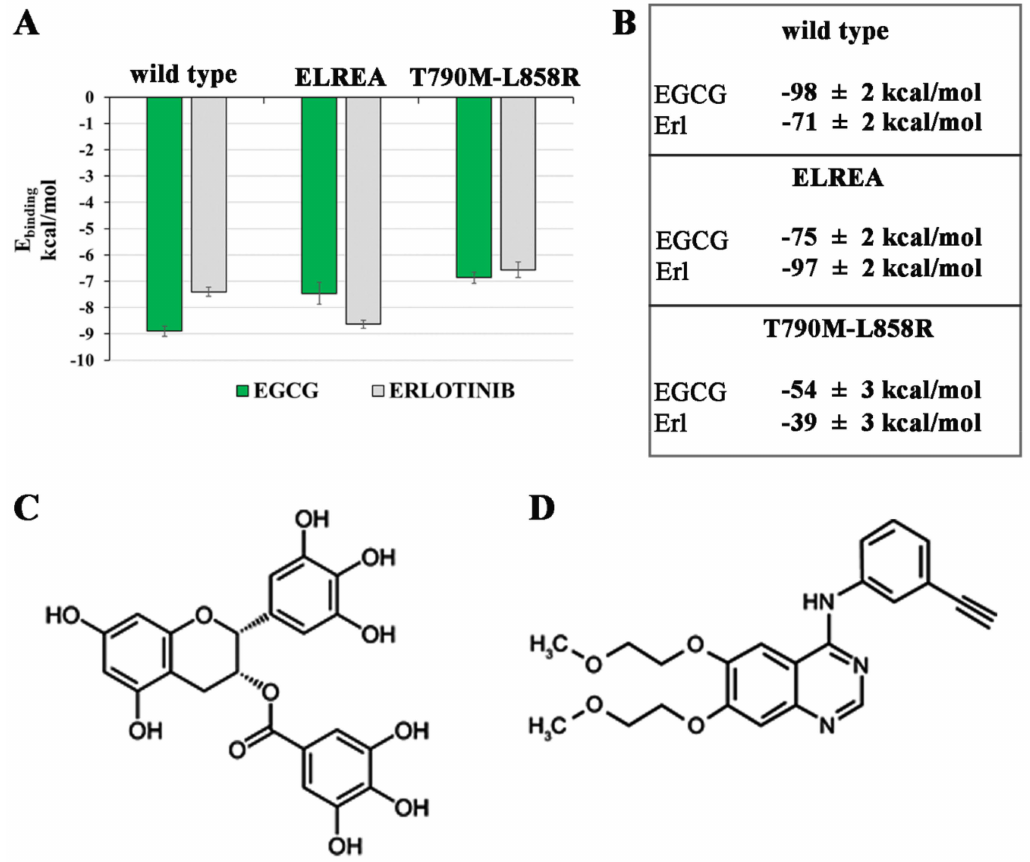
Figure 6. Binding energy of Epigallocatechin-3-gallate (EGCG) and Erlotinib in association of wild type, ELREA deletion and T790M / L858R mutated EGFR forms obtained with the molecular docking ( A ) and molecular dynamics approach ( B ). We reported the total MM / PBSA energy calculated in the last 5 ns of MD simulation in kcal / mol.; 2D structure of EGCG ( C ) and Erl ( D